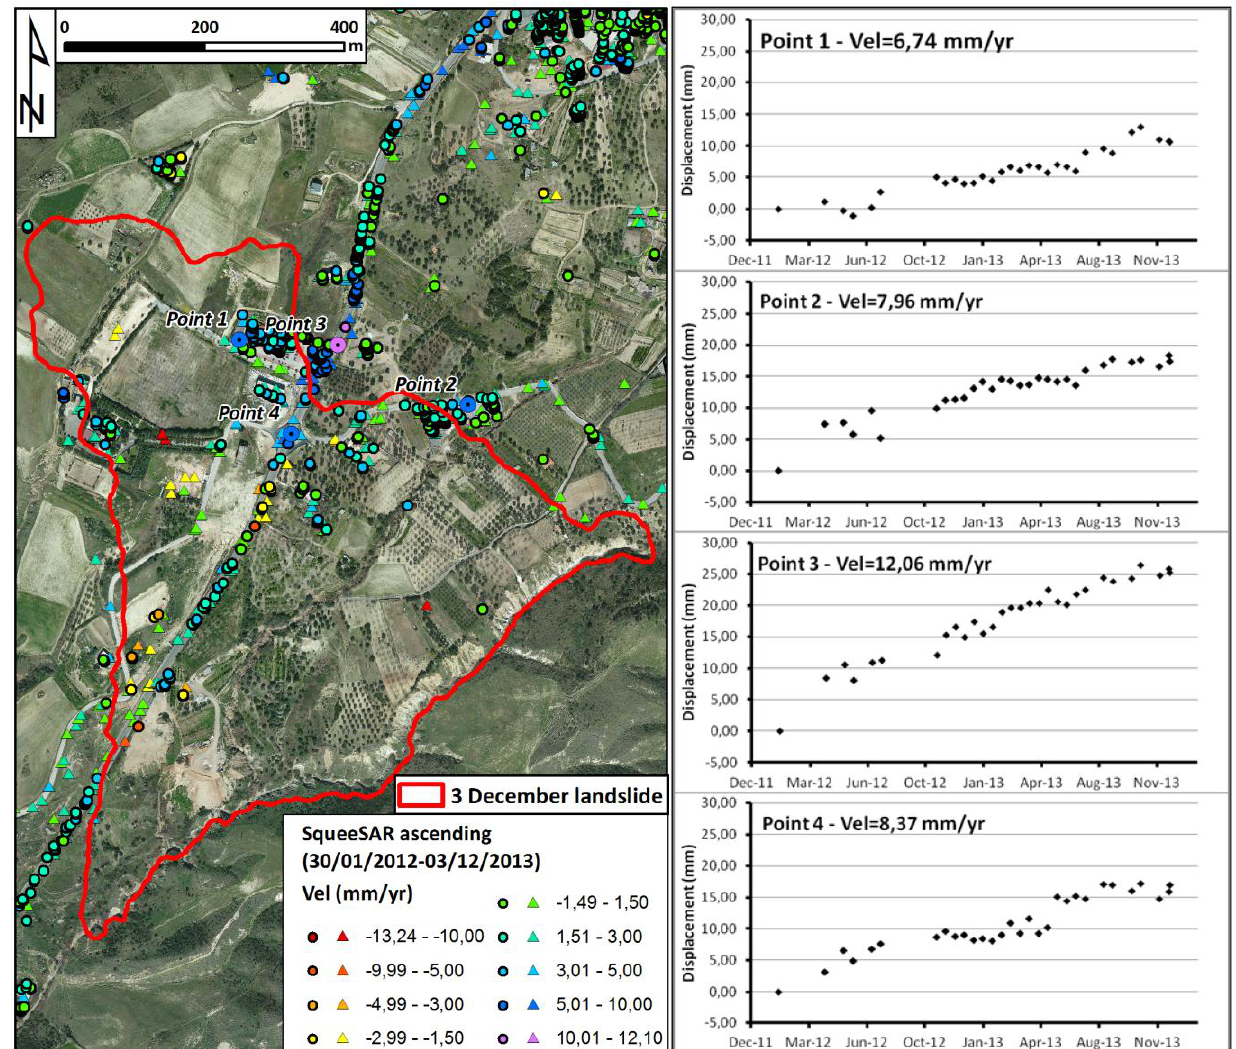
Figure 5. Pre-event SqueeSAR results for the area of Montescaglioso